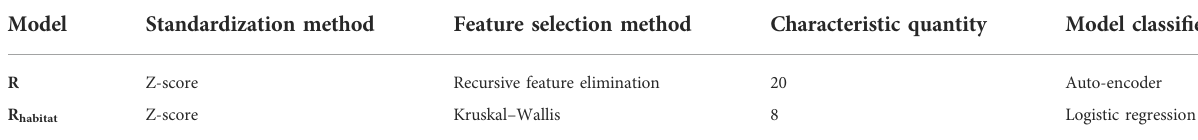
TABLE 2 Description of two models.